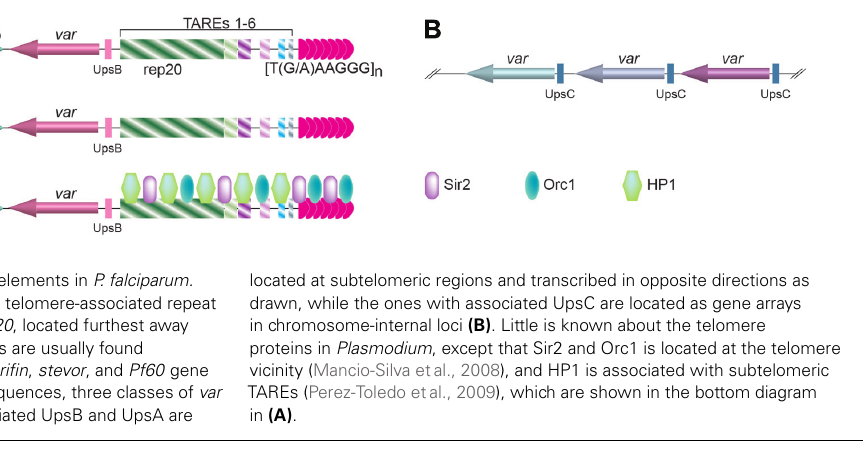
FIGURE 2 | (A) The organization of subtelomere elements in P. falciparum. Immediately internal to the telomere tract are six telomere-associated repeat elements (TAREs 1 – 6), with the largest one, rep20 , located furthest away from the telomere repeats. One or two var genes are usually found immediately upstream of rep20 , followed by the rifin , stevor , and Pf60 gene families. Depending on the upstream flanking sequences, three classes of var genes have been identified.The ones with associated UpsB and UpsA are